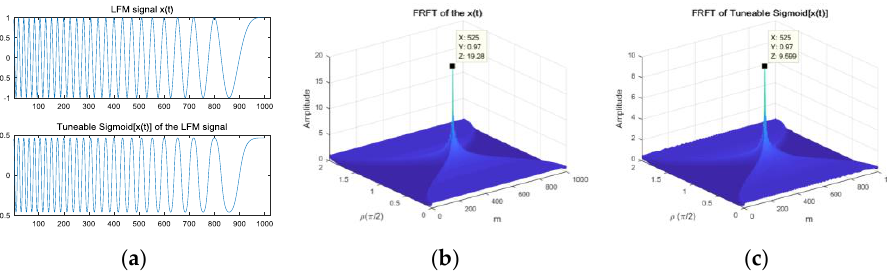
Figure 5. The LFM signal in the time domain and the FRFT domain. ( a ) the LFM signal and the tuneable Sigmoid[x(t)]; ( b ) the FRFT of the LFM signal; ( c ) FRFT of the the tuneable Sigmoid[x(t)].